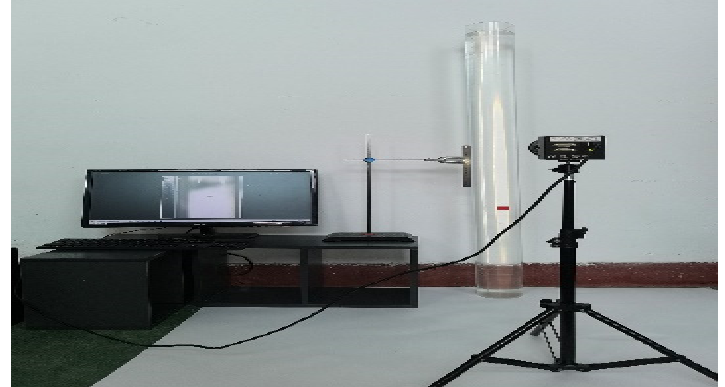
Figure 6. Particle sedimentation test